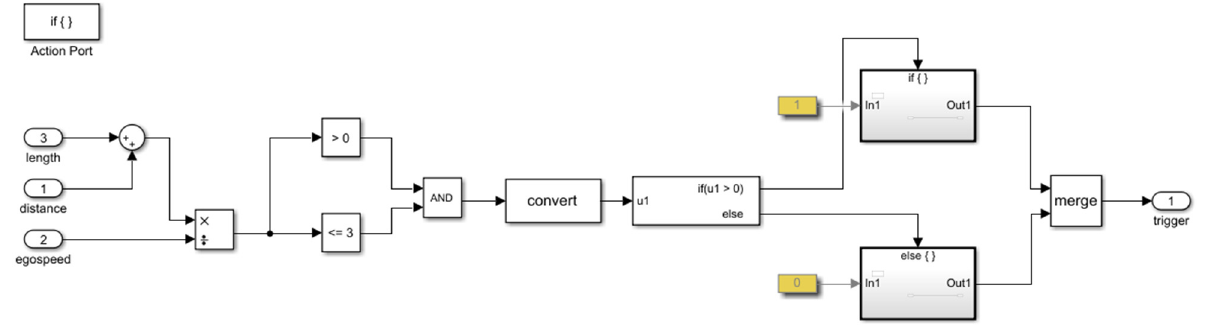
Figure 9. Time headway trigger warning in Simulink.